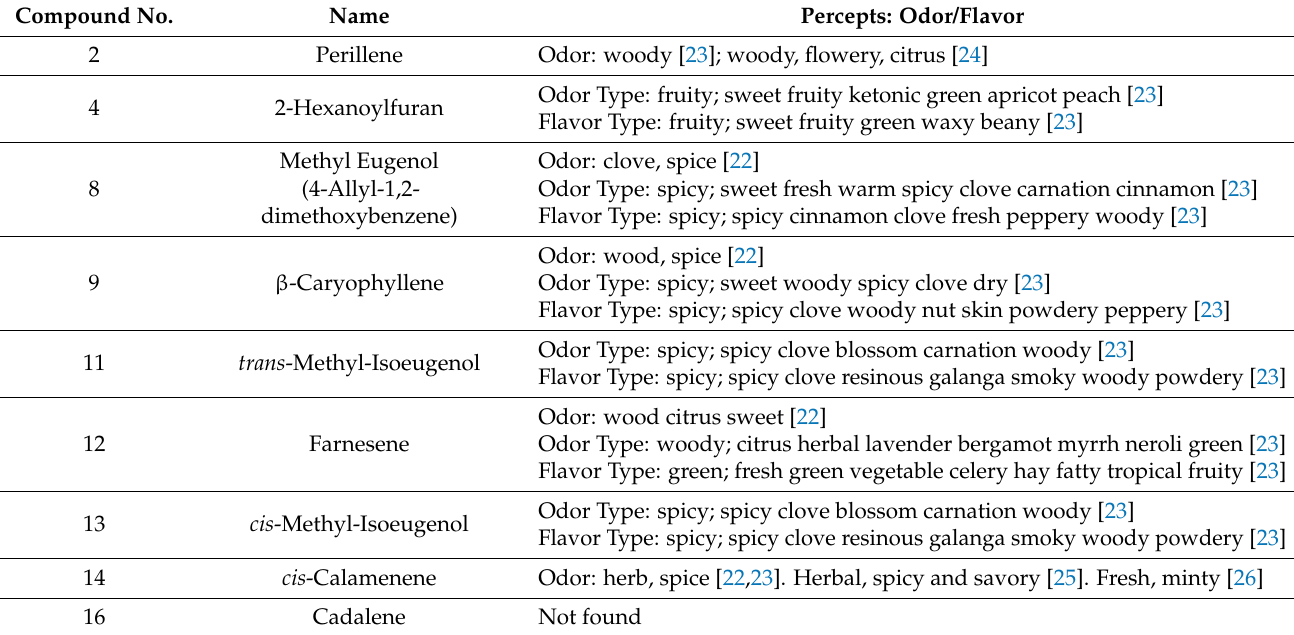
Table 6. Perception of the aromatic compounds of Chinese green basil. Compound